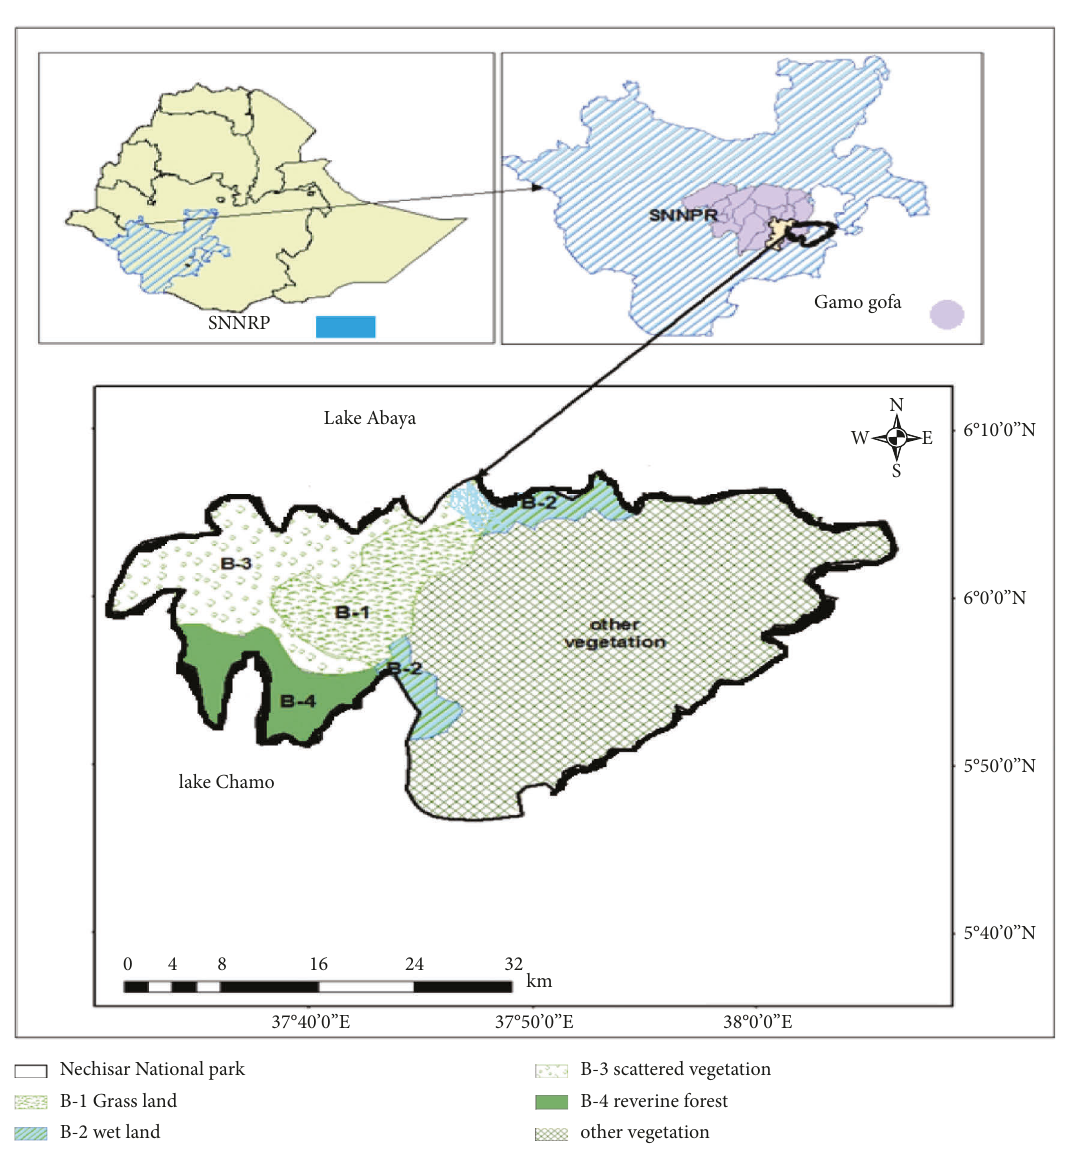
Figure 1: Map of the study